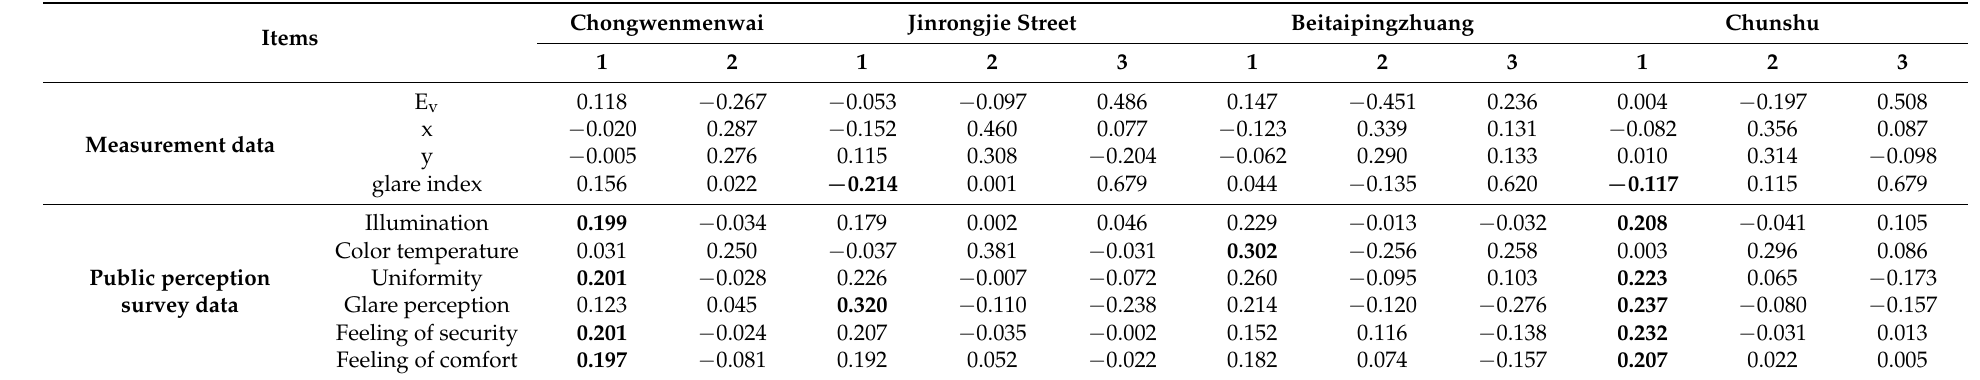
Table 6. The score coefficient matrix of each route